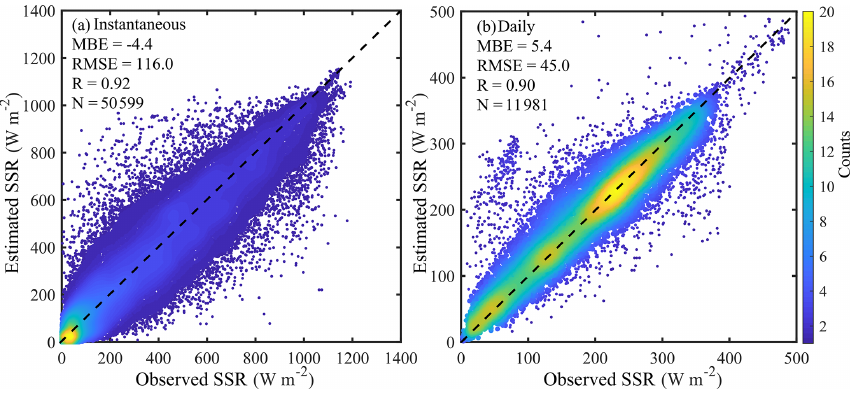
Figure 6. Comparison of CERES SSR products with observed SSR at 42 BSRN stations for both (a) instantaneous and (b) daily scales.